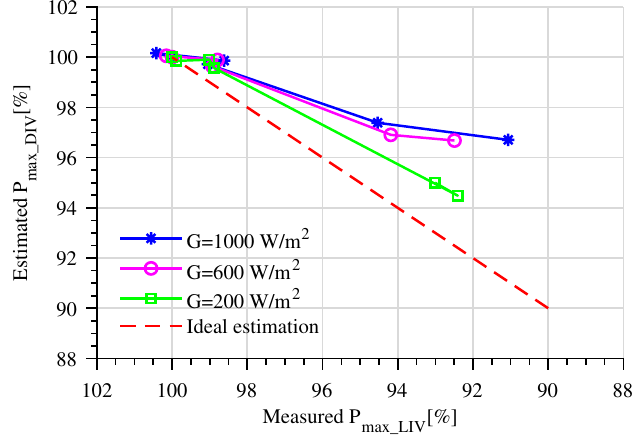
Figure 9. Estimated module #1 power loss by dark I-V superposition ( P max _ DIV ) and series resistance compensation (dark I-V estimated— R s _ DIV ), versus actual measured power loss ( P max _ LIV ), at 1000, 600, and 200 W/m 2 irradiance.